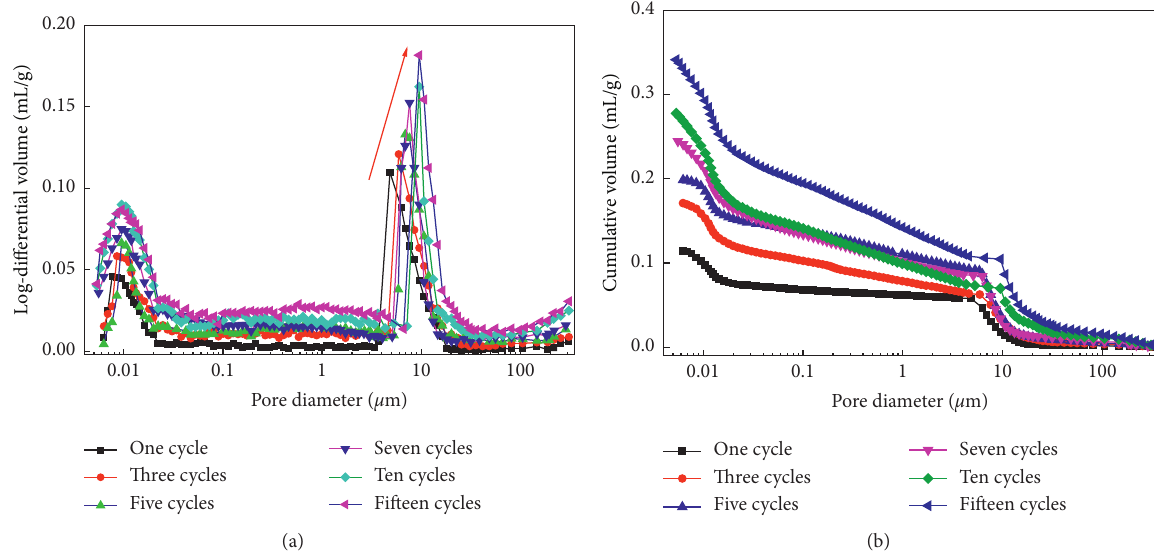
Figure 6: Pore size distribution of improved soils with different numbers of drying-wetting cycles for (a) log-differential distribution and (b) cumulative